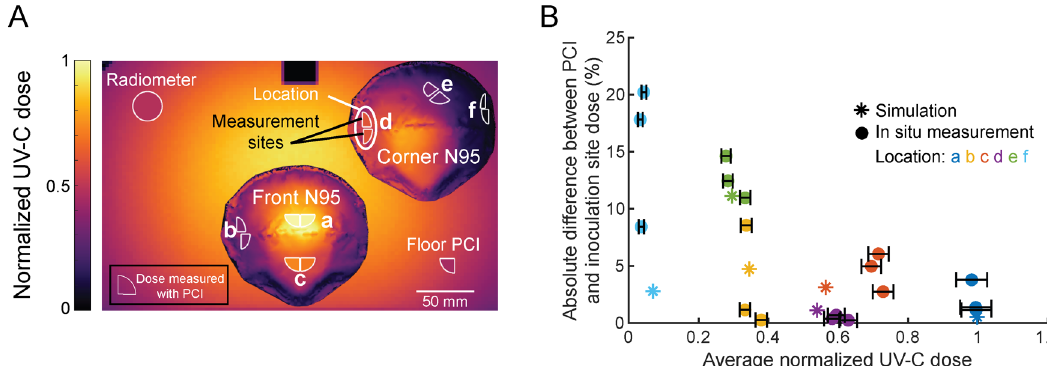
Figure 4. Optical simulation and PCIs identify paired measurement sites receiving equivalent UV-C dose within locations on N95 facepieces receiving a wide range of UV-C doses for paired dose and viral inactivation measurements. ( A ) Optical simulation of UV-C dose distribution over two 3M 1860 N95 facepieces in the UV-C chamber, overlaid with PCIs at paired measurement sites for viral inactivation and dose measurement. Heatmap shows simulated UV-C dose (normalized to the maximum dose in the chamber). PCI fill color represents the mean dose measured with PCIs in situ across triplicate measurements. ( B ) Comparison of dose differences within paired measurement sites. Data are colored by on-N95 location. Horizontal error bars on measured values represent the 95% confidence interval in estimated dose (Note